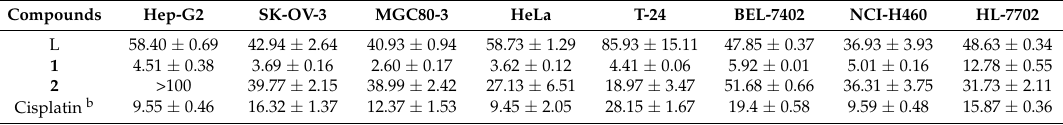
Table 1. The IC 50 a ( µ M) values of L, complexes 1 and 2 to the selected tumor cells for 48 h. Compounds Hep-G2 SK-OV-3